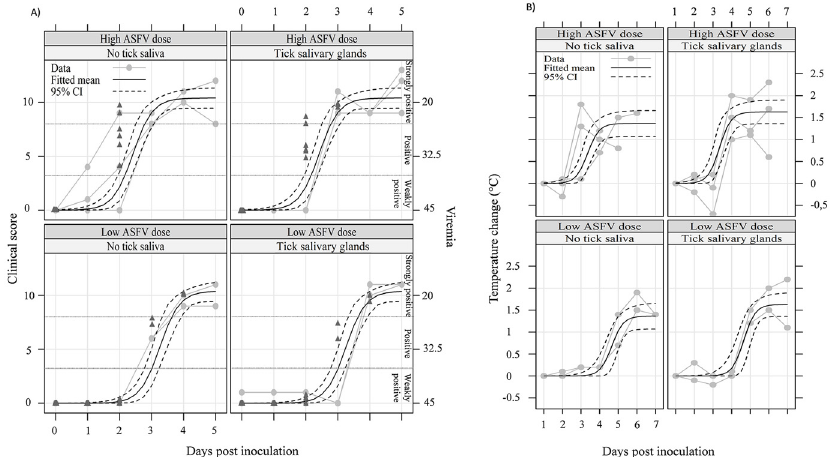
Fig 1. Clinical scores, viraemia and rectal temperature. (A) The scale for clinical score is shown on the left, and the scale for individual real-time PCR results is shown on the right. Real-time PCR results (dark grey triangles) were categorized as negative ( C t > 45), weakly positive (44 (cid:3) C t > 37), positive (36 (cid:3) C t > 26) and strongly positive ( C t < 25). (B) Changes in pig rectal temperature were recorded with respect to the inoculation day. The mean was estimated with a nonlinear logistic model fitted by generalized least